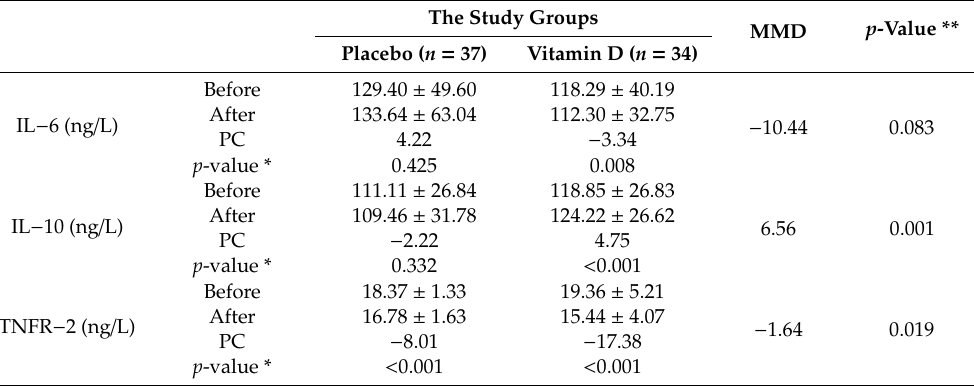
Table 5. Comparing the inflammatory markers in study groups before and after